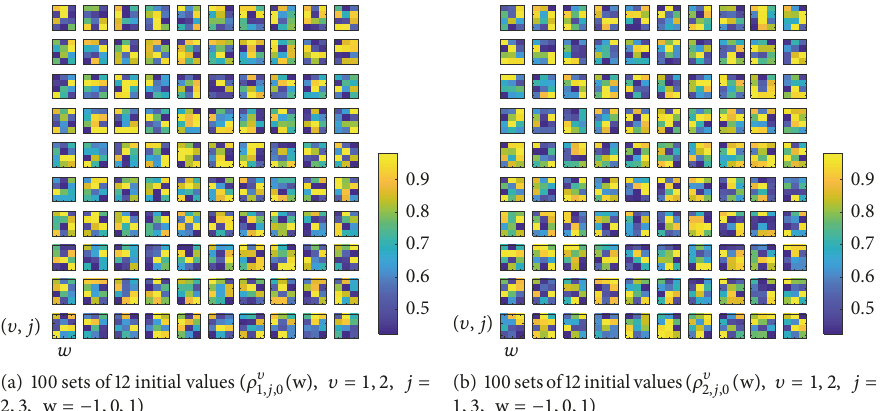
Figure 4: Initial values for the sequences. Due to the recursive relations in (47), (48), (54), and (55), it is enough to independently consider the convergences of the two types of the sequences 𝜌 𝜐 1,𝑗,𝑛 (𝑤) (𝜐 = 1, 2, 𝑗 = 2, 3, 𝑤 = −1,0, 1) and 𝜌 𝜐 2,𝑗,𝑛 (𝑤) (𝜐 = 1, 2, 𝑗 = 1, 3, 𝑤 = −1,0, 1) . (a) Each set contains values of 12 initial terms 𝜌 𝜐 1,𝑗,0 (𝑤) (𝜐 = 1,2, 𝑗 = 2,3, 𝑤 = −1,0,1) for each experimental data set. (b) Each set contains values of 12 initial terms 𝜌 𝜐 2,𝑗,0 (𝑤) (𝜐 = 1, 2, 𝑗 = 1, 3, 𝑤 = −1,0,1) for each experimental data set.